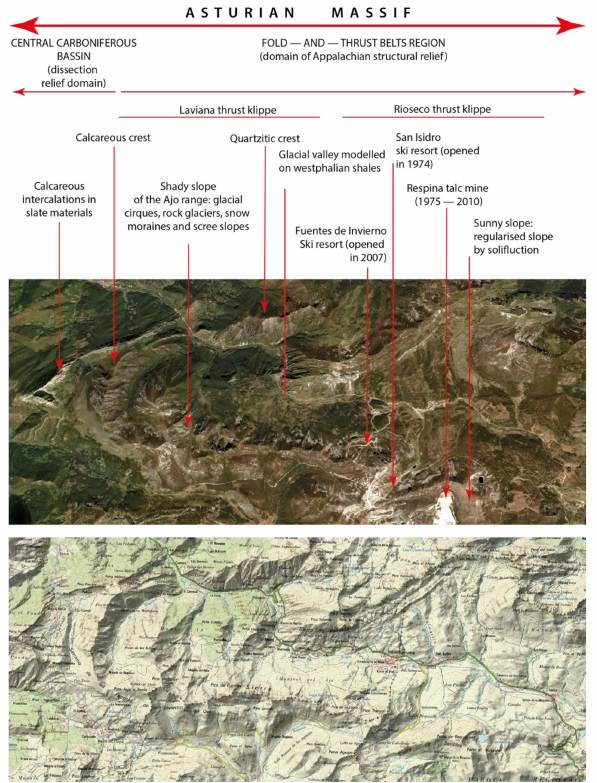
Figure 2. General view (Google Earth image from 2007) of San Isidro Mountain pass showing the most important geomorphic features and location map (IGN Iberpix Orthopotos and